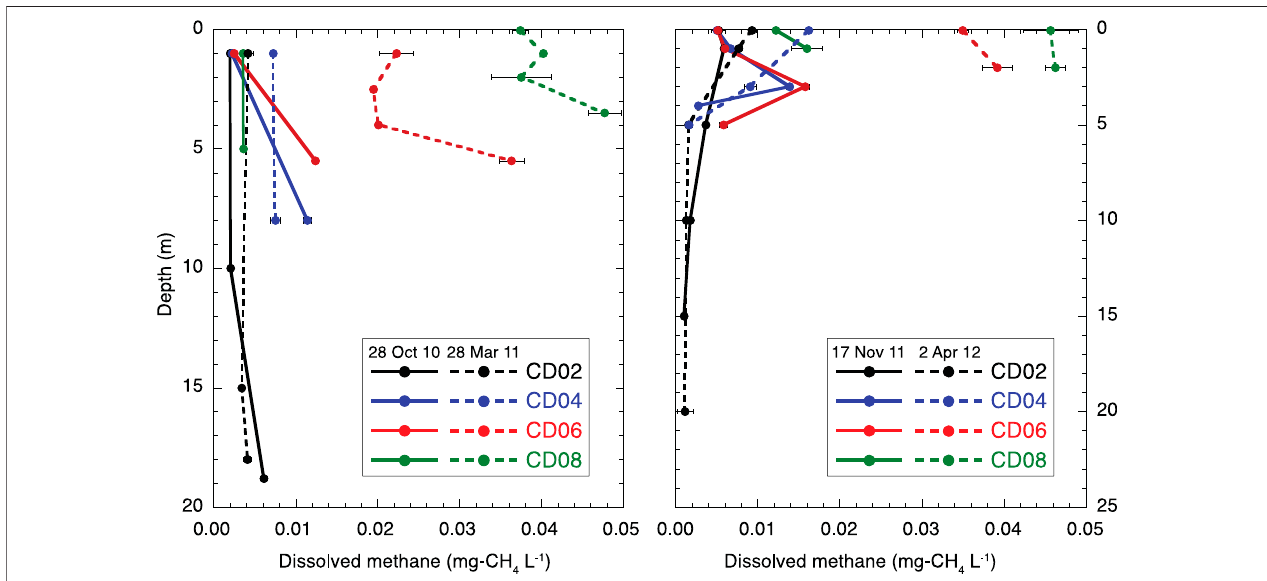
FIGURE 6 | Depth pro fi les of dissolved CH 4 on 28 October 2010 (solid), 28 March 2011 (dashed), 17 November 2011 (solid), and 2 April 2012 (dashed) at sites CD02 (black), CD04 (blue), CD06 (red) and CD08 (green). Error bars denote 1 standard deviation ( n = 2).